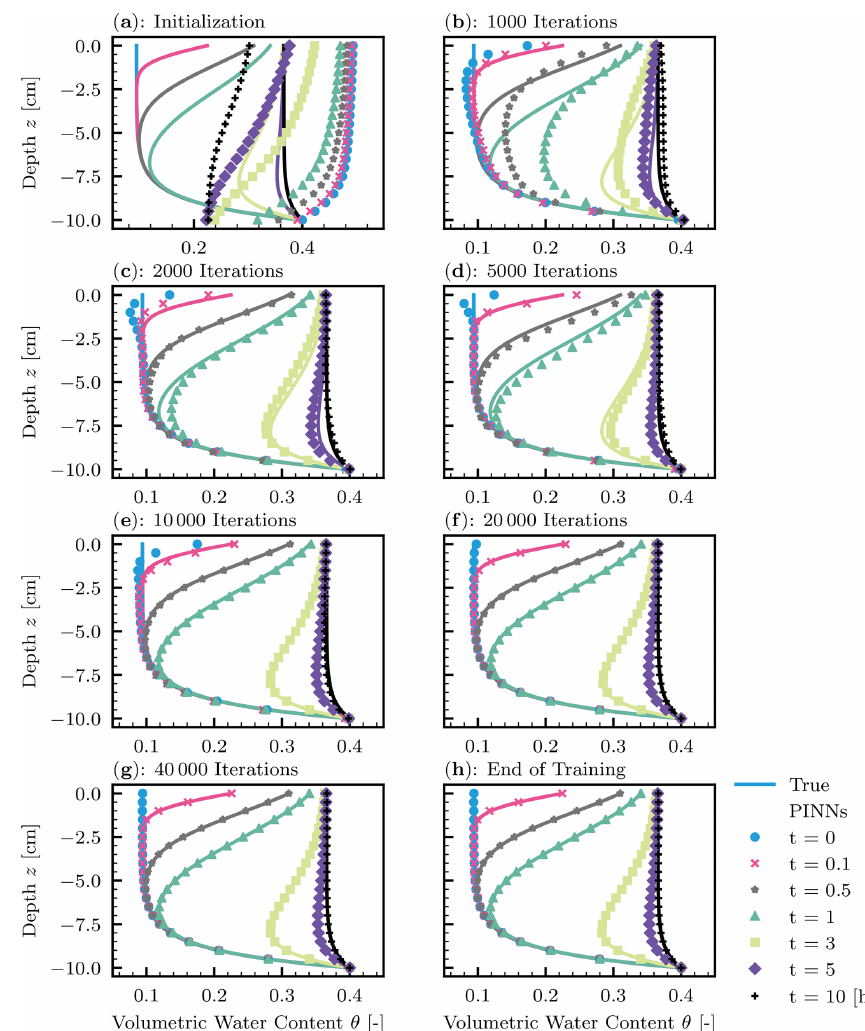
Figure 5. Homogeneous soil. The evolution of physics-informed neural network (PINN) solution (points) during the training with the true solution (solid lines). (a) Initialization of PINNs. (b–g) 1000, 2000, 5000, 10000, 20000, and 40000 iterations of the Adam algorithm. (h) The end of 100000 iterations of the Adam algorithm and the following L-BFGS-B